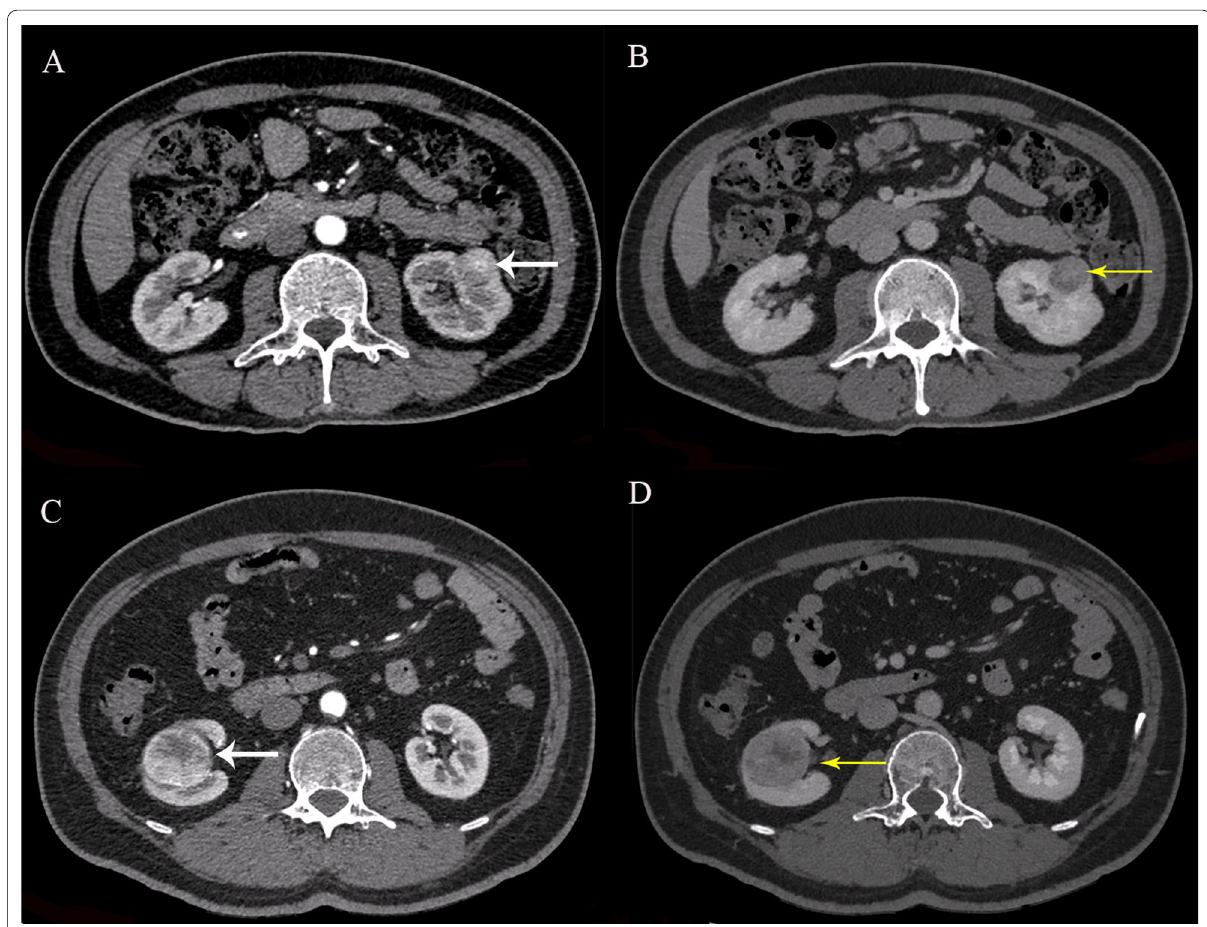
Fig. 5 Images showed that a 58-year-old man had clear cell carcinoma of the left kidney with a diameter of 23.9 mm ( A , B ). The CT value of the lesion in the corticomedullary phase image ( A ) was similar to that of normal renal cortical enhancement. The lesion was not significant in the corticomedullary phase but could be clearly displayed on 60-keV nephrographic phase VMIs (virtual mono-energetic images) ( B ). Images showed that a 47-year-old man had clear cell carcinoma of the right kidney with a size of 41.4 mm 35.0 mm ( C , D ). The lesion visibility was superior on × corticomedullary phase images ( C ) than on 60 keV VMIs ( D